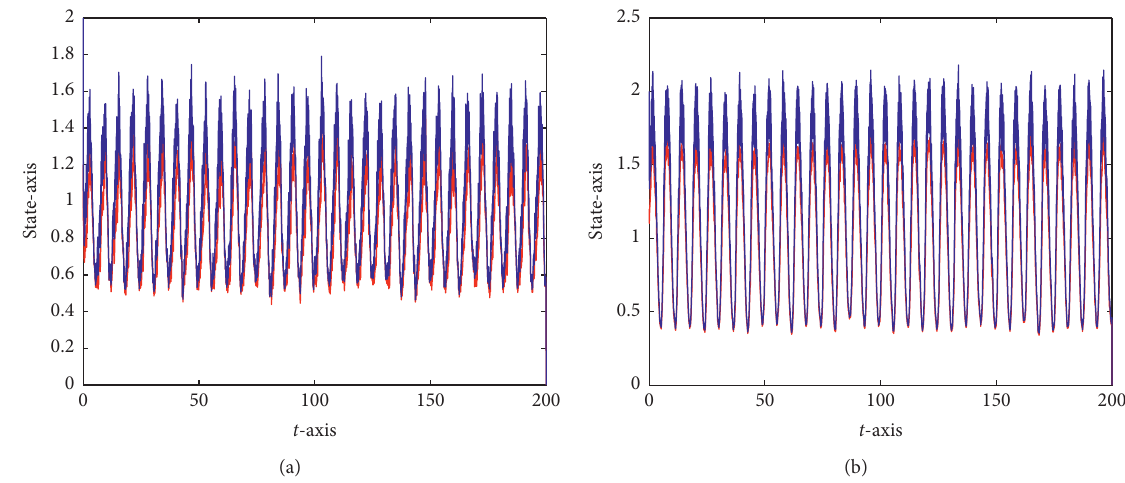
Figure 3: The attractivity of x attractivity of x